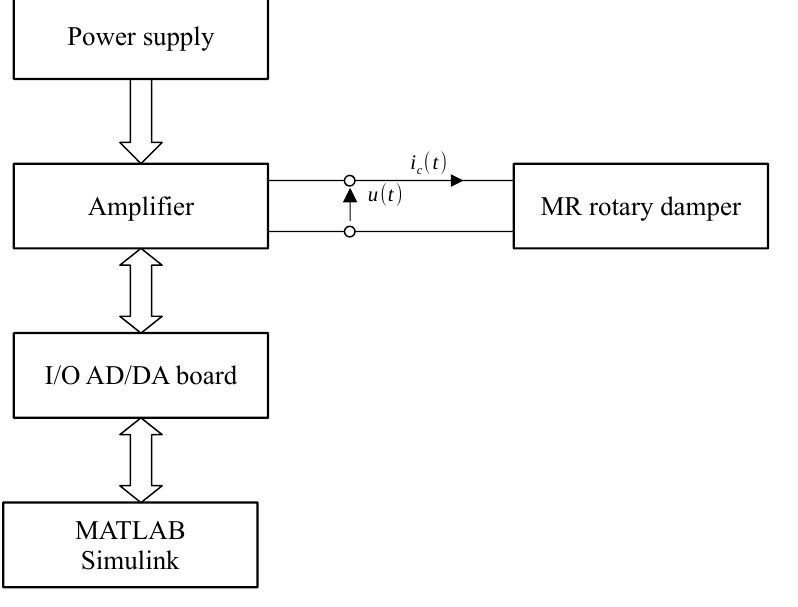
Figure 4. Data acquisition